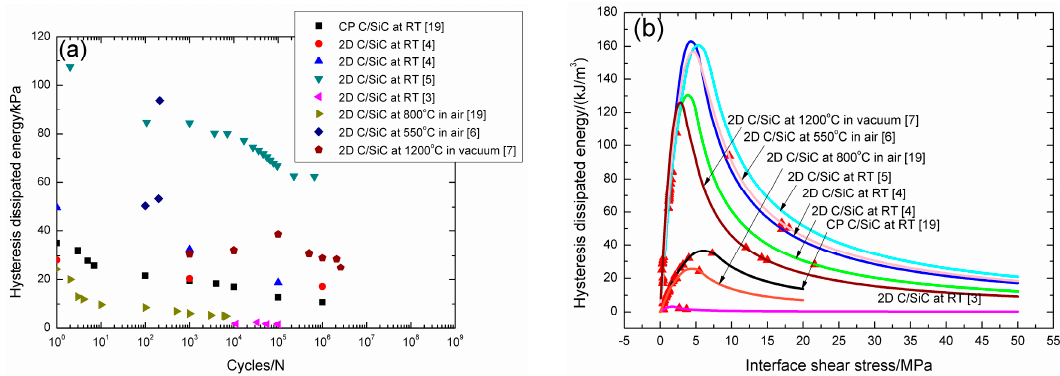
Figure 17. ( a ) The experimental fatigue hysteresis dissipated energy versus applied cycles; and ( b ) the experimental and theoretical fatigue hysteresis dissipated energy versus interface shear stress curves of cross-ply and 2D woven C/SiC composites at room and elevated temperatures.